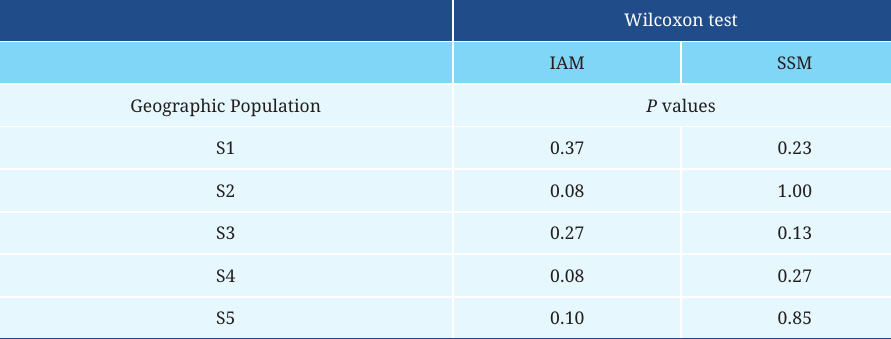
TABLE 3 | Wilcoxon test for detection of recent bottleneck events in the studied sites. IAM = Infinite Alleles Model; SMM = Stepwise Mutation